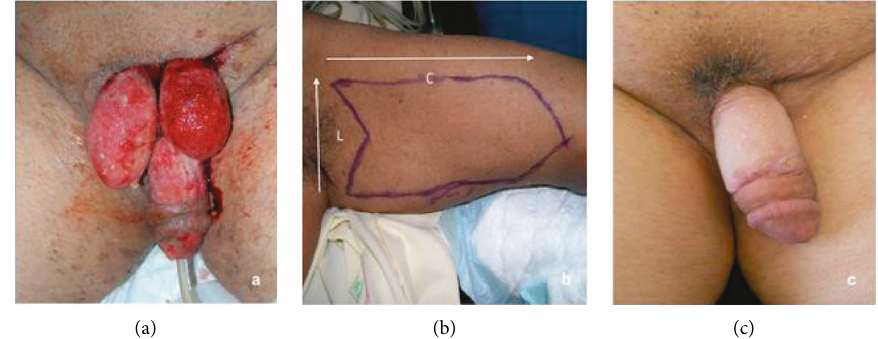
Figure 1: (a) Granulation tissue after debridement and local care. (b) Arrow-shaped drawing on donor skin graft site. (c) Outcomes at 1 year, testicles set in the internal side of the